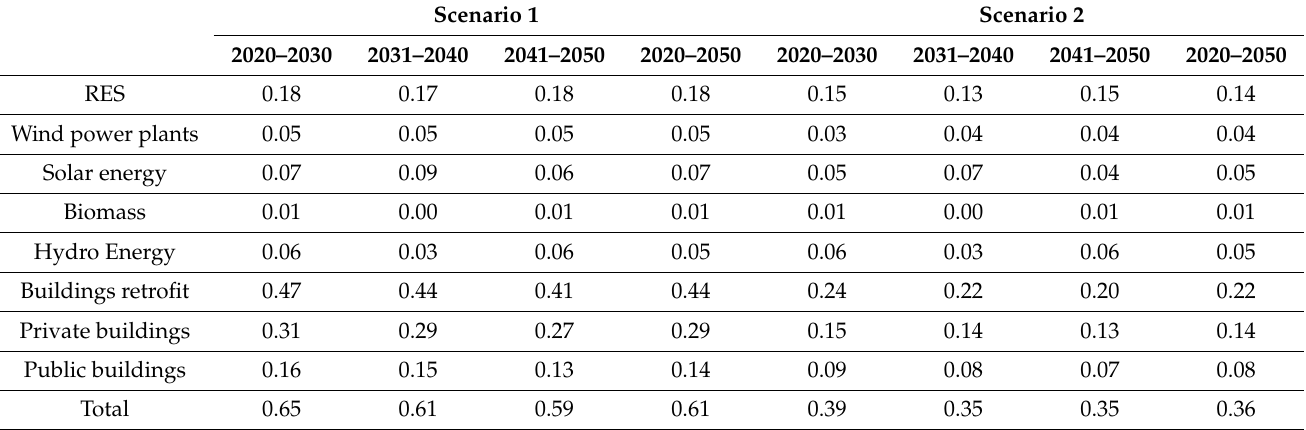
Table 5. GVA induced by energy transition, as % of GDP.